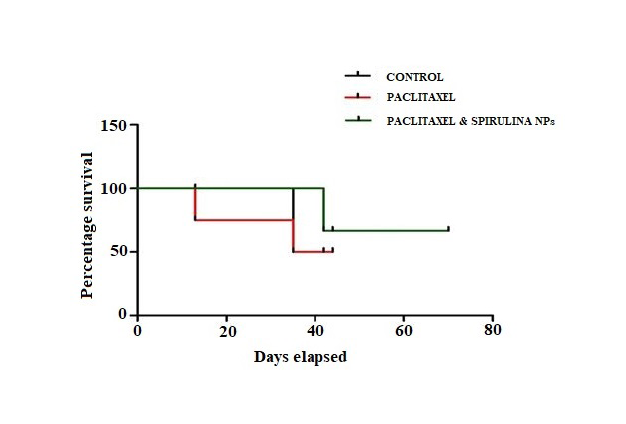
FIGURE 4 - Kaplan-Meier survival curves of gastric cancer xenograft bearing mice. The day when tumor tissues were inoculated into the mice is defined as day 0. The statistical significance of differences in the survival curves between the groups were evaluated using the log-rank test.